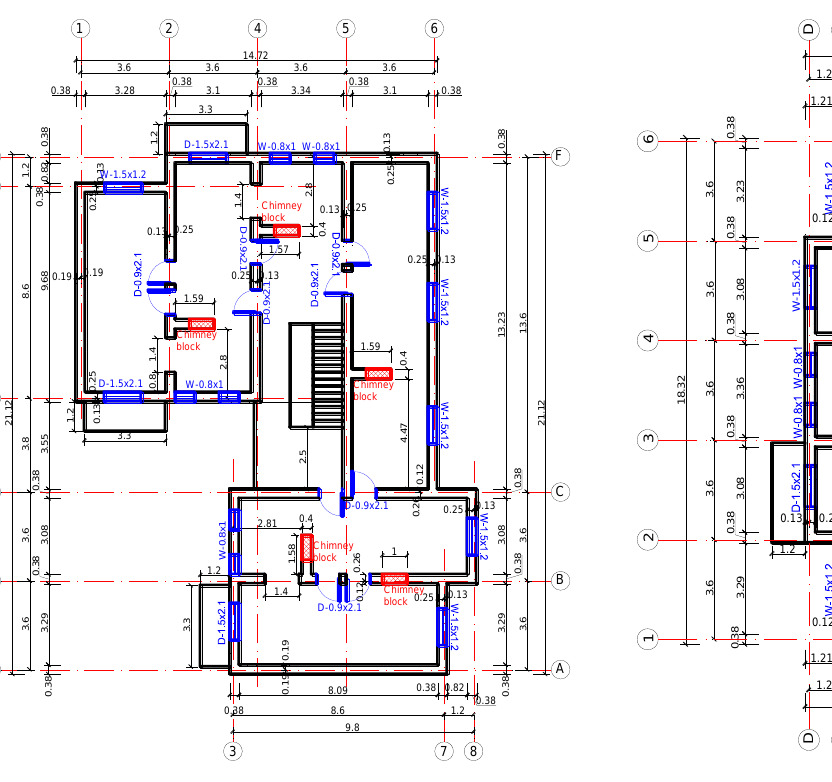
Figure 2. Template design 72/3, (National Archive of Albania, 1983) Fig. 2. Template design 72/3, (National Archive of Albania, 1983). Figure 3. Template design 72/1, (National Archive of Albania, 1983) Fig. 3. Template design 72/1, (National Archive of Albania,